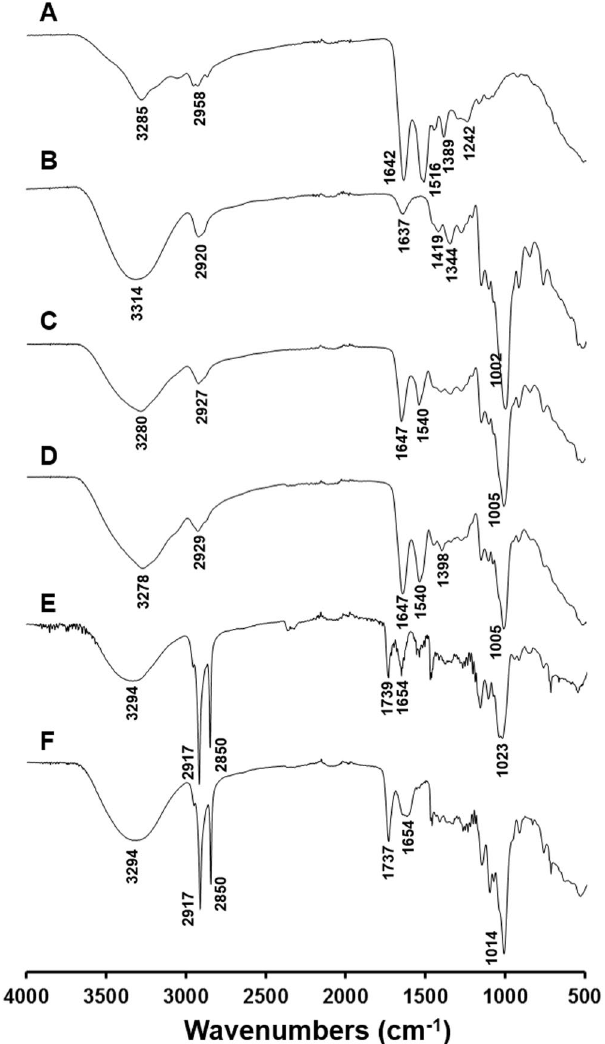
Figure 8. FT-IR spectra of: ( A ) BSA, ( B ) Dextran (M.W = 75 kDa), ( C ) Physical mixture of dextran and BSA, ( D ) Maillard conjugate (Group Dex75-3), ( E ) LPN, ( F ) Pectin-coated